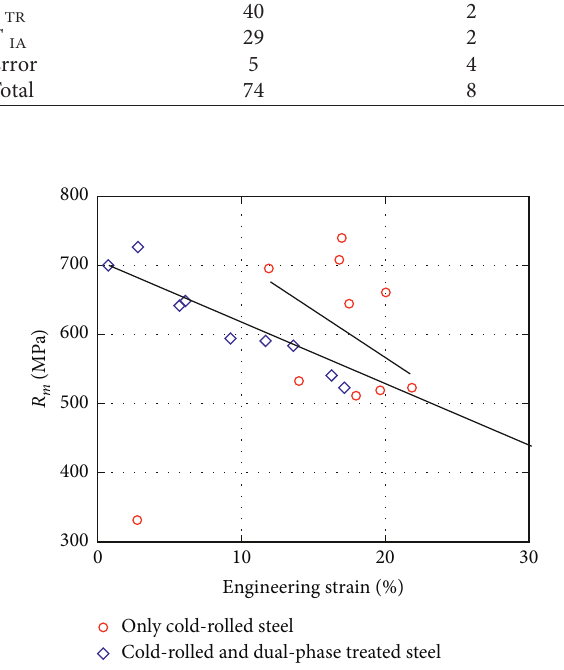
Figure 10: Comparison of combination of UTS and elongation of the cold-rolled and dual-phase treated steel.